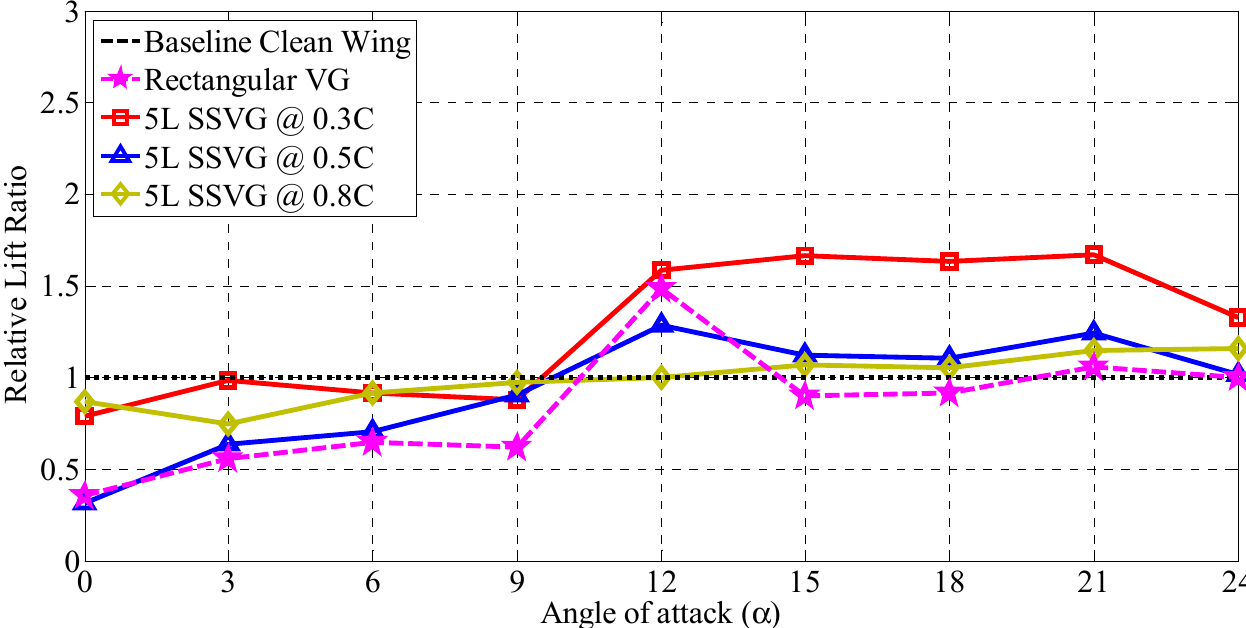
Figure 15. Relative lift ratio vs. angle of attack ( α ) for baseline and modified model for large-sized (5L) SSVG.